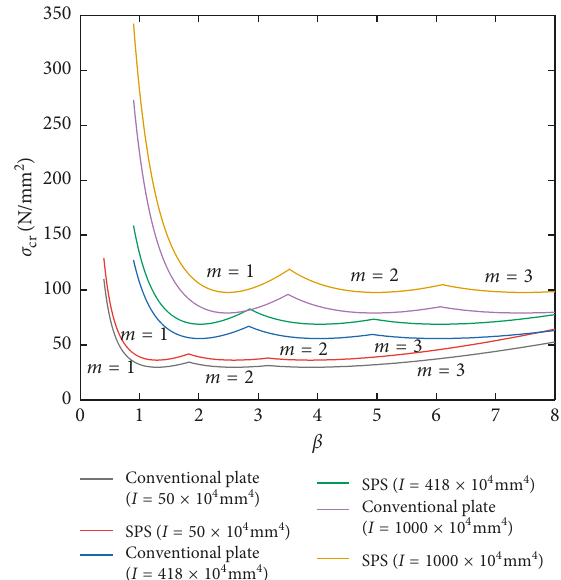
Figure 9: Relation between β and critical buckling stress for different inertia moments of a single rib in the SPS and steel